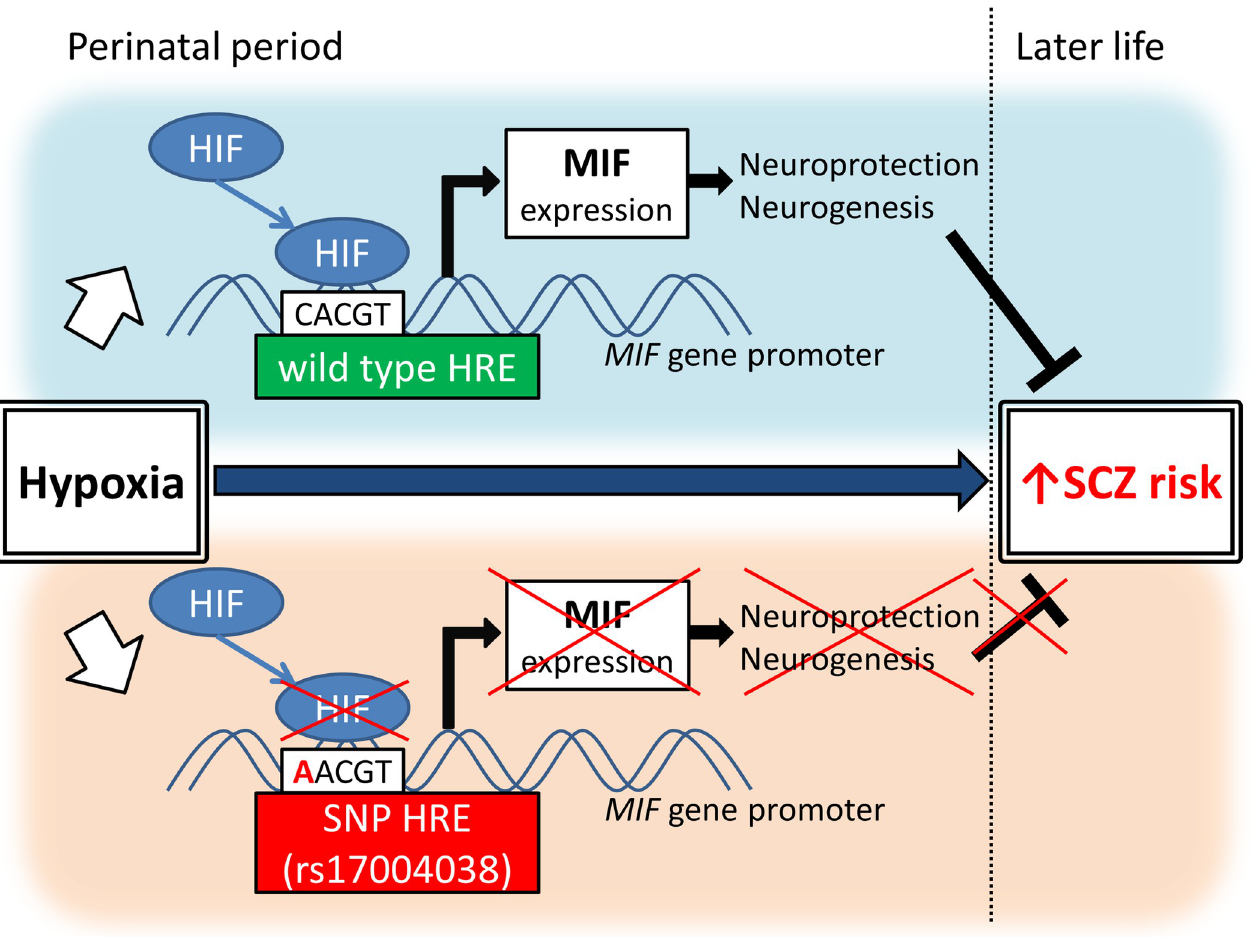
Fig 4. Putative roles of single nucleotide polymorphism (SNP) rs17004038 in the hypoxia response element (HRE) of the macrophage migration inhibitory factor ( MIF ) gene promoter in perinatal hypoxia-associated schizophrenia (SCZ) risk. Abbreviation: HIF, Hypoxia-inducible factor.